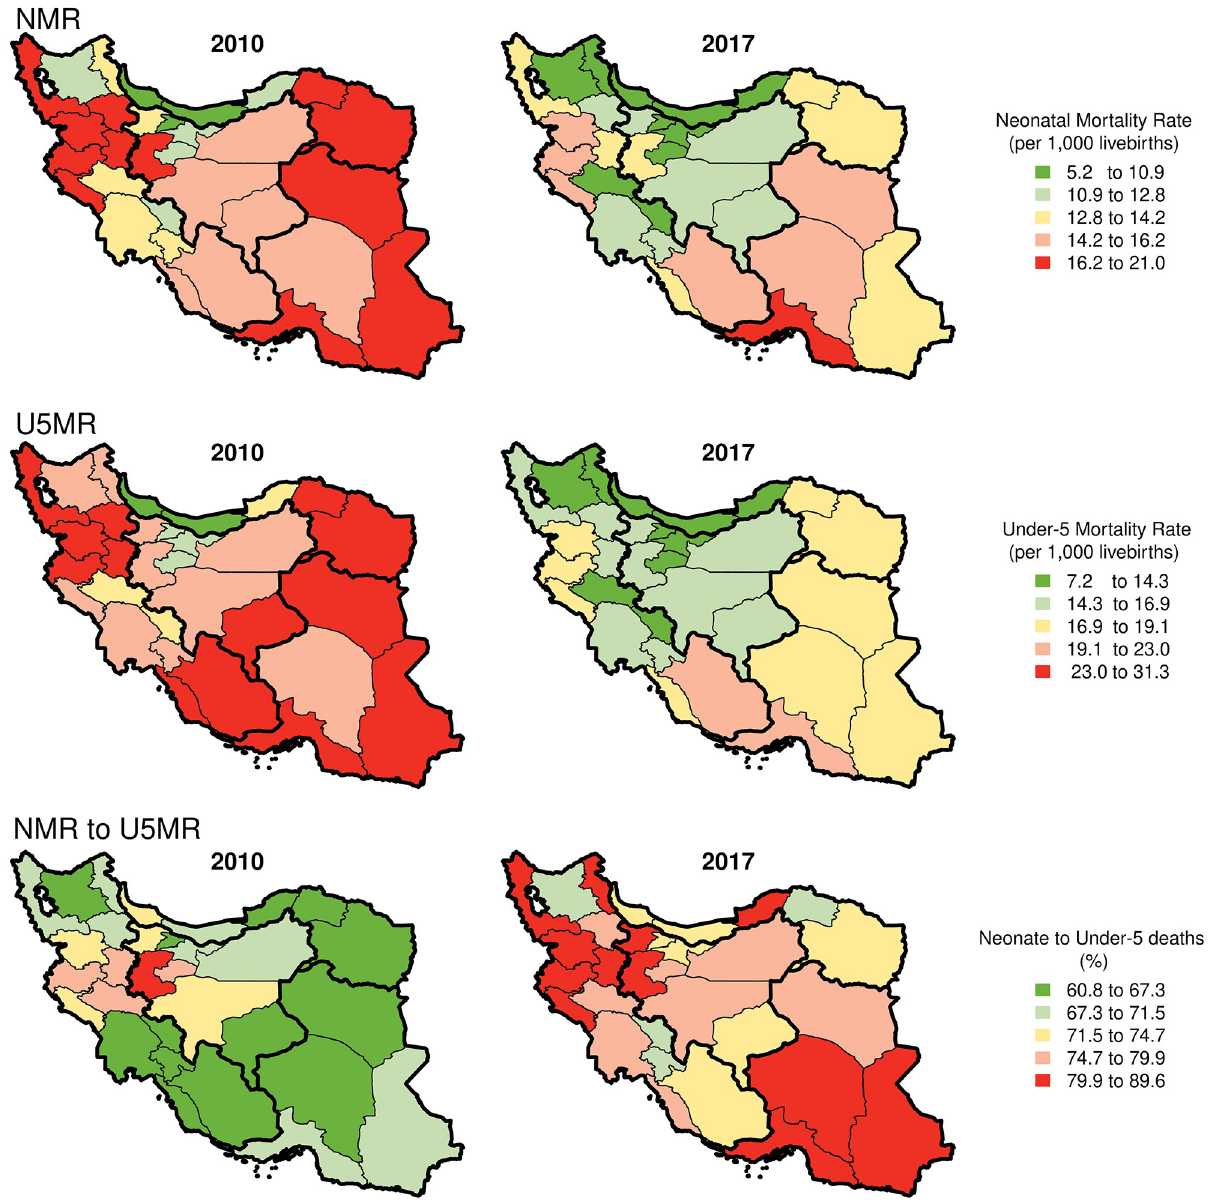
Fig 2. Map of the provincial U5MRs, NMRs, and neonatal share of under-5 mortality rates in 2010 and 2017 (contains information from OpenStreetMap and OpenStreetMap foundation, which is made available under the open database license).